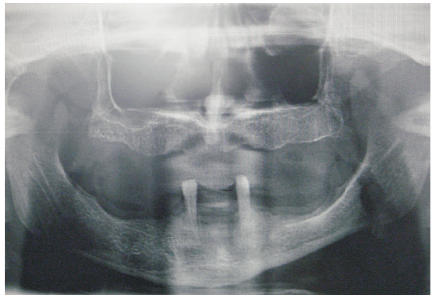
Figure 1: Panoramic radiograph of patient with two poor- prognosed mandibular teeth.